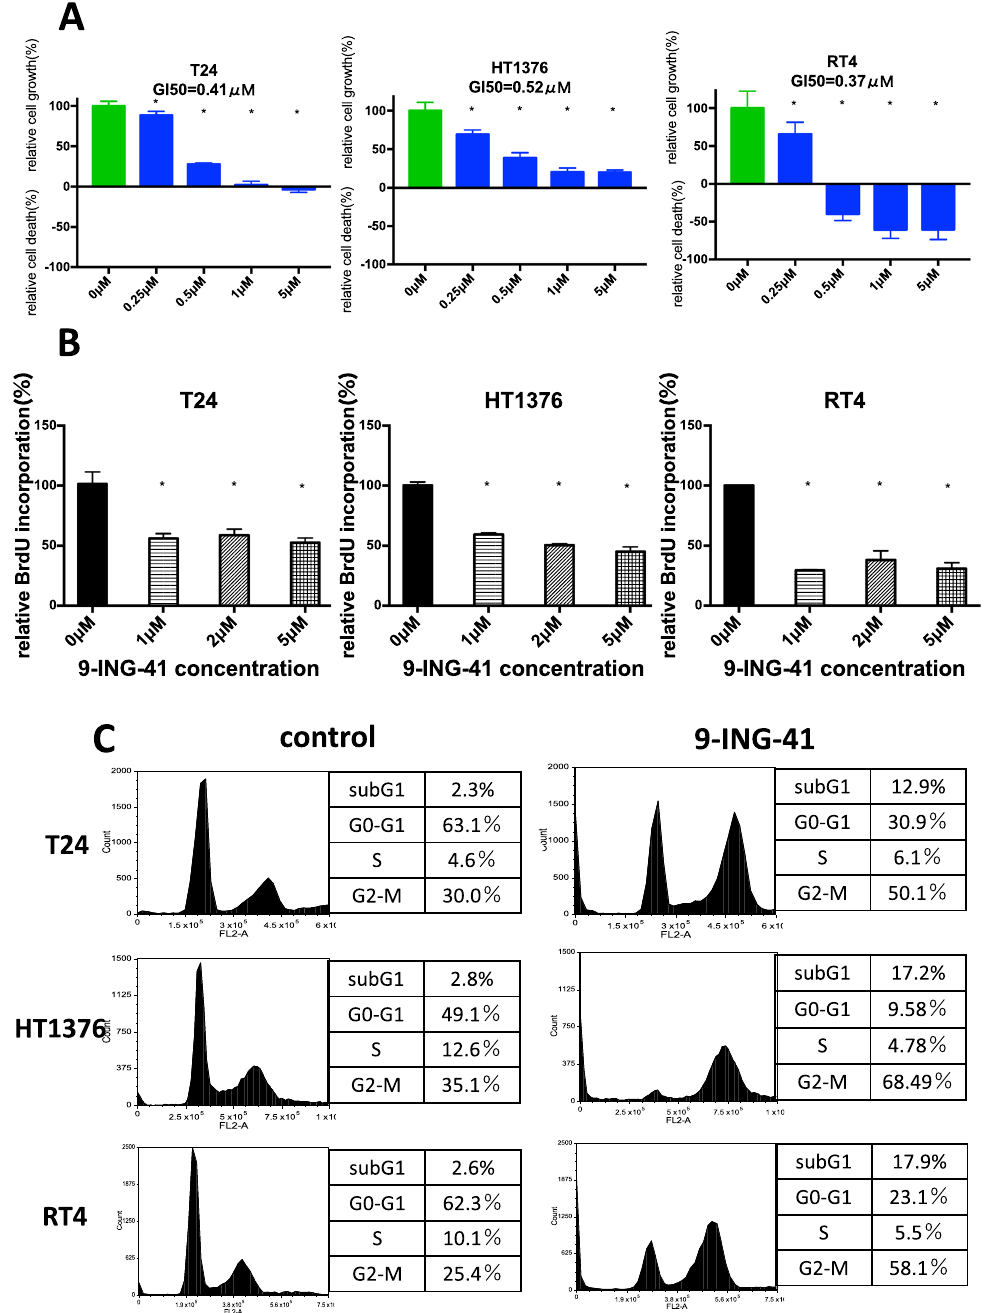
Figure 1. Treatment with 9-ING-41 decreases proliferation and survival of bladder cancer cells. ( A ) Relative cell viability of bladder cancer cells treated with the indicated doses of 9-ING-41 for 96 hours was measured by MTS assay. * P < 0.05 by one-way ANOVA with Tukey post-hoc test. ( B ) BrdU colometric assay was done using bladder cancer cells treated with 9-ING-41 at indicated concentrations for 48 hours. Columns, mean; bars, SD. * P < 0.05 by one-way ANOVA with Tukey post-hoc test. ( C ) Flow cytometry was performed using T24, HT1376 and RT4 bladder cancer cells treated with 10 μ M of 9-ING-41 for 72 hours. Cell cycle distribution and fraction of sub-G1, G1, S and G2 population are